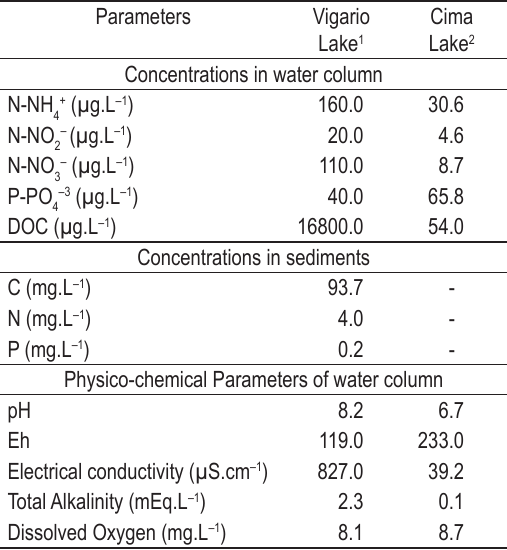
Table 1. Nitrogen, Phosphorus and Organic Carbon in waters and the sediment of Lake Vigário and Lake Cima (References: 1 Lannes, 2004 and 2 Santos,